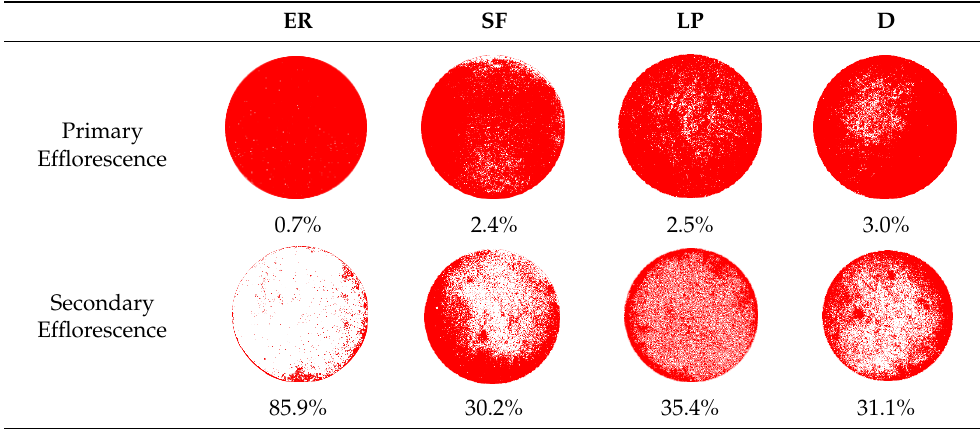
Table 4. Efflorescence area percentage of cement mortars.